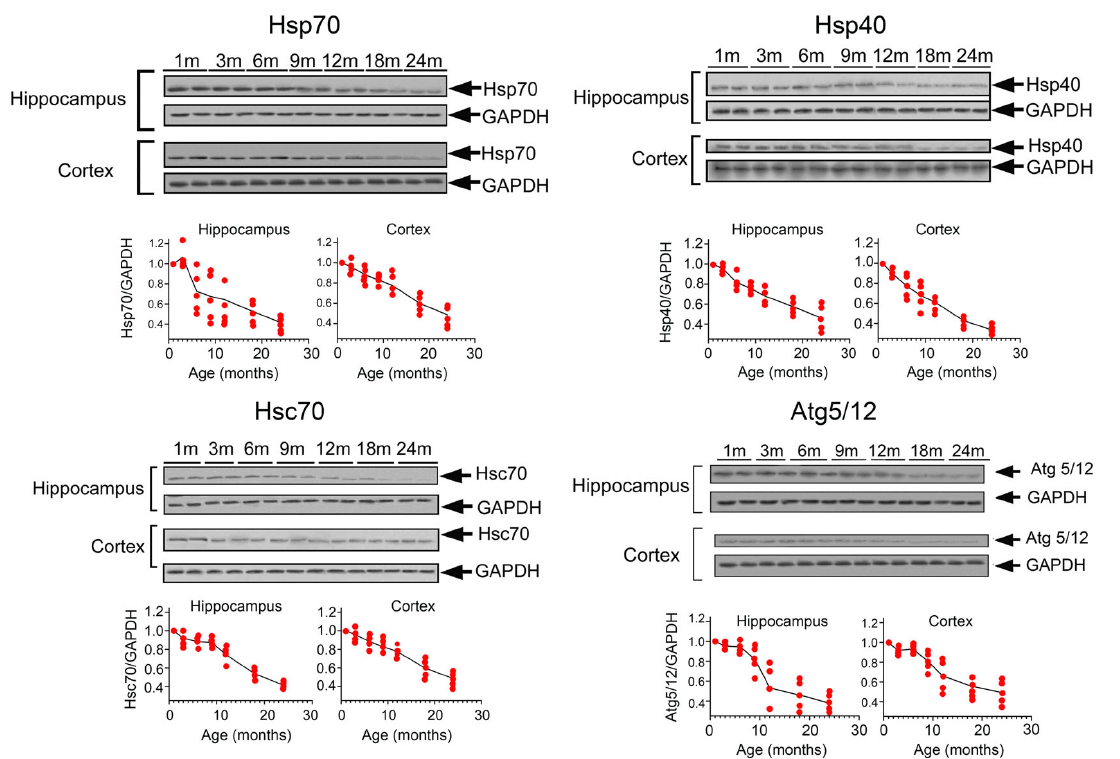
Figure 1. Expression of proteins involved in proteostasis reduces with mouse ageing. Hippocampus and cortex tissues from untreated mice at ages 1, 3, 6, 9, 12, 18 and 24 months ( n = 5 in each age group) were used for Western blotting. On the top of each panel, representative immunoblots of the hippocampus and cortex lysates with antibodies to molecular chaperones and autophagy markers are shown; on the bottom, the calculation of the intensity of the protein zones of interest to the intensity of the zones of the normalizing protein GAPDH. Each point corresponds to one animal.